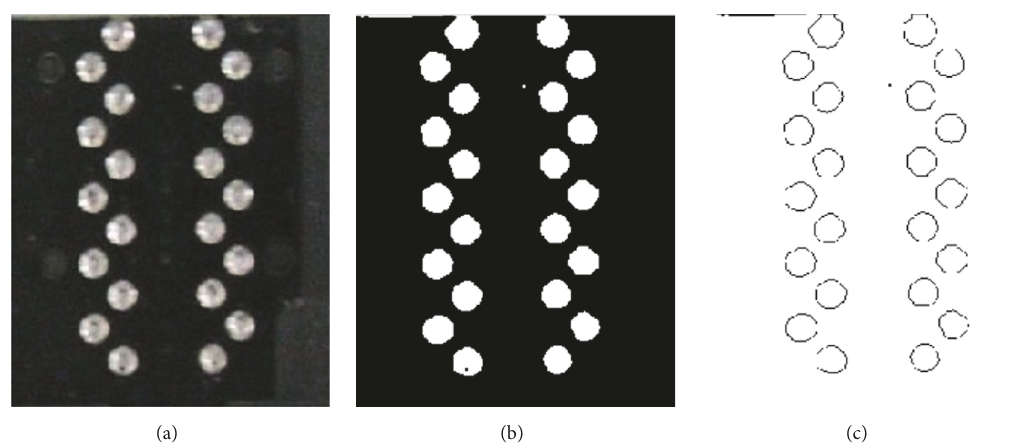
Figure 3: Solder joint image preprocessing: (a) original image; (b) HPD image binarization; (c) final morphological processing result.